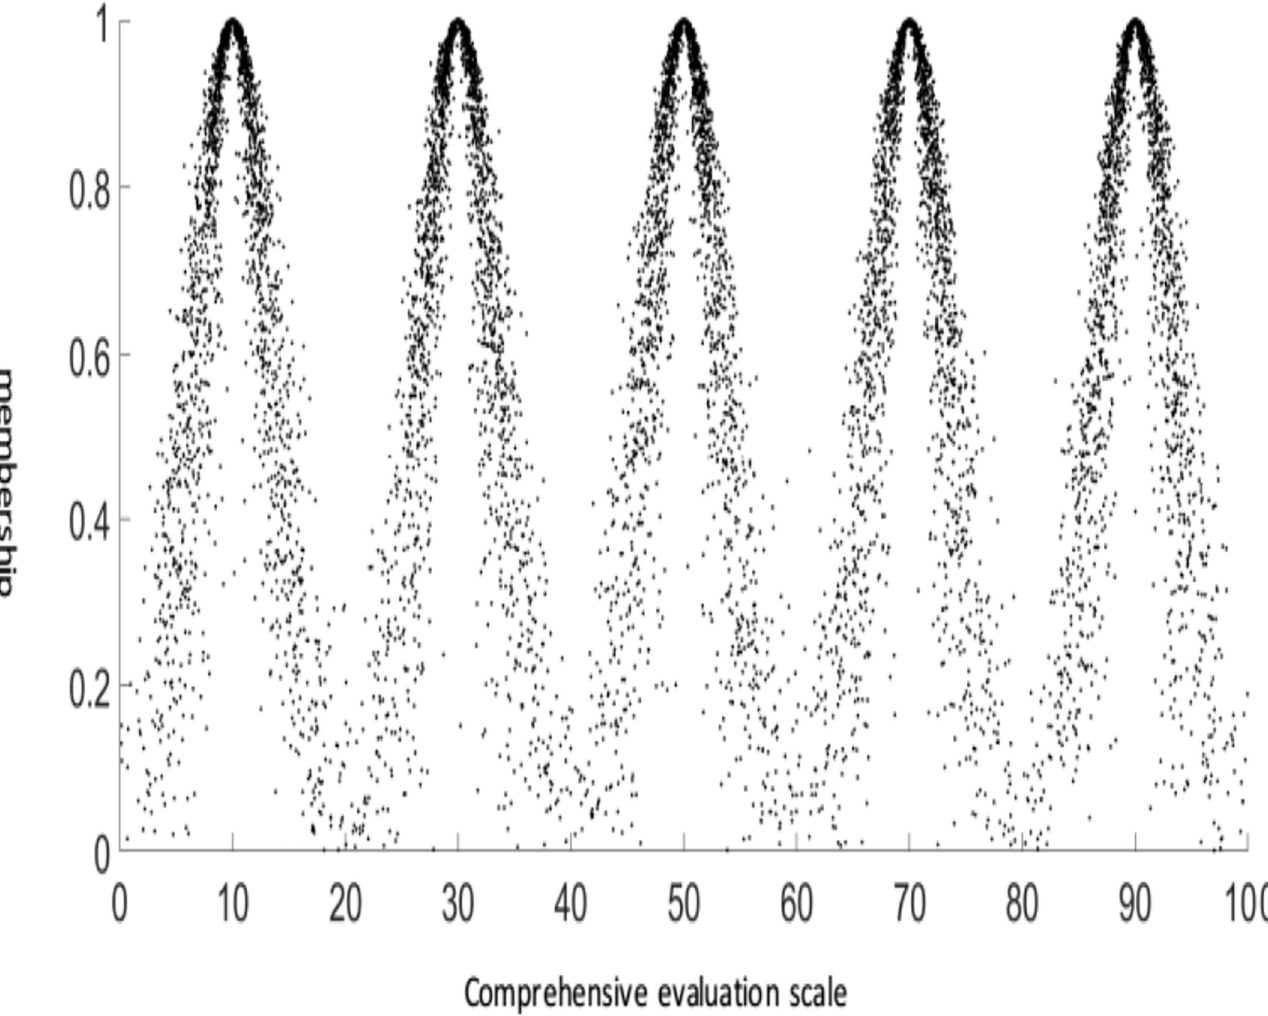
Fig 4. Evaluation of landslide risk assessment based on the cloud model.